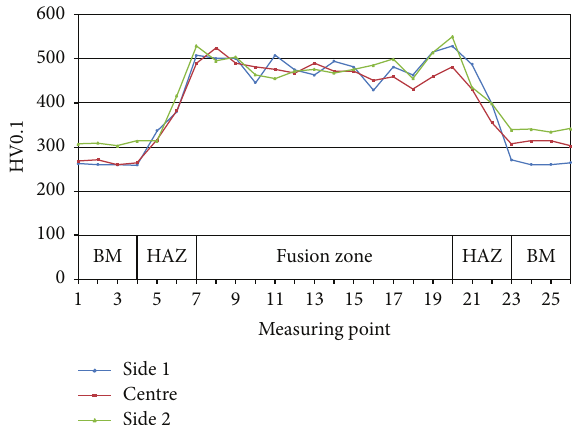
Figure 6: Microhardness values of a sample welded at a heat input of 0.051kJ/mm measured along three lines of the cross section (at a centre of the sheet thickness and near top and bottom